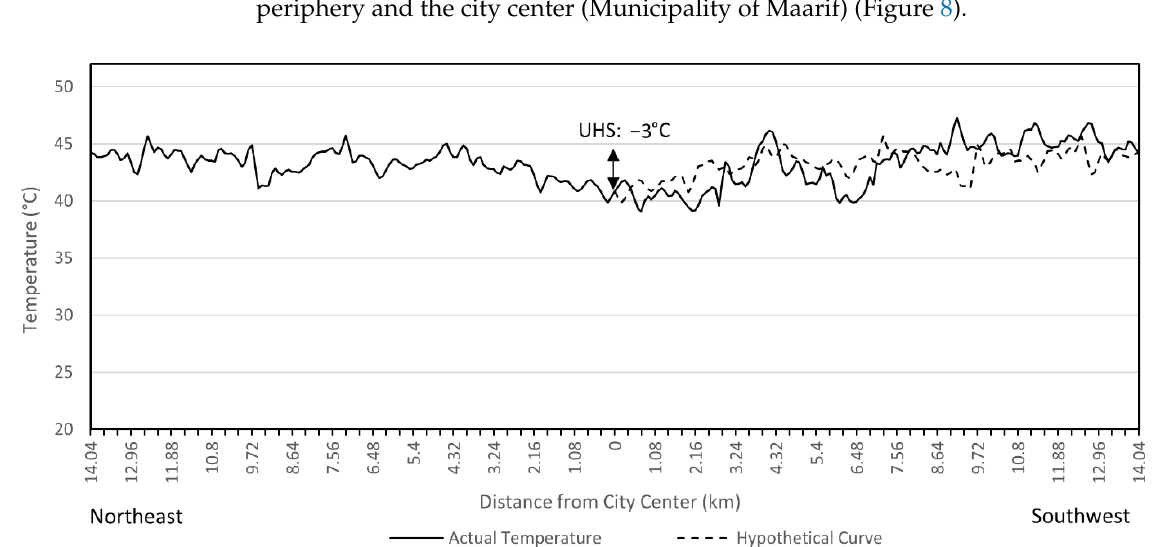
Figure 7. Surface temperature cross section along a north-south transect perpendicular to the coastline and across the city of Casablanca.